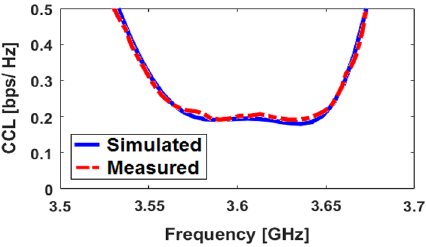
Figure 16. Calculated CCL function for the corresponding array.